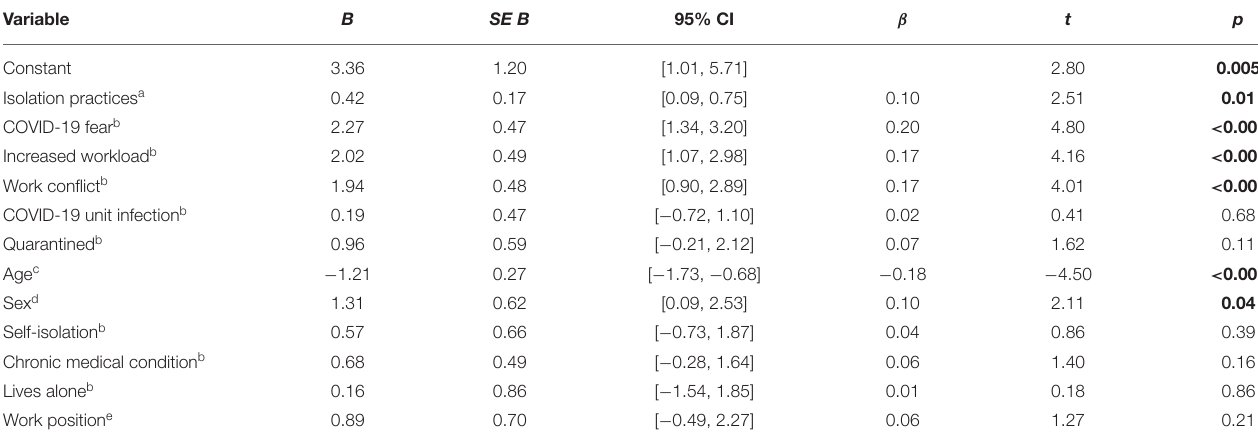
TABLE 5 | Multiple linear regression analysis for worker variables predicting GAD-7 anxiety score. Variable B SE